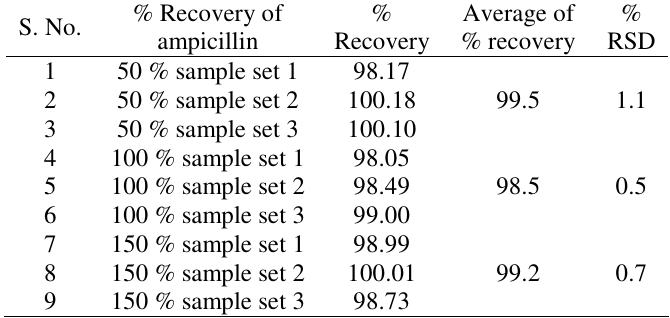
Table 2. Accuracy of the method for the determination of amiciline and dicloxacillin capsule dosage form.